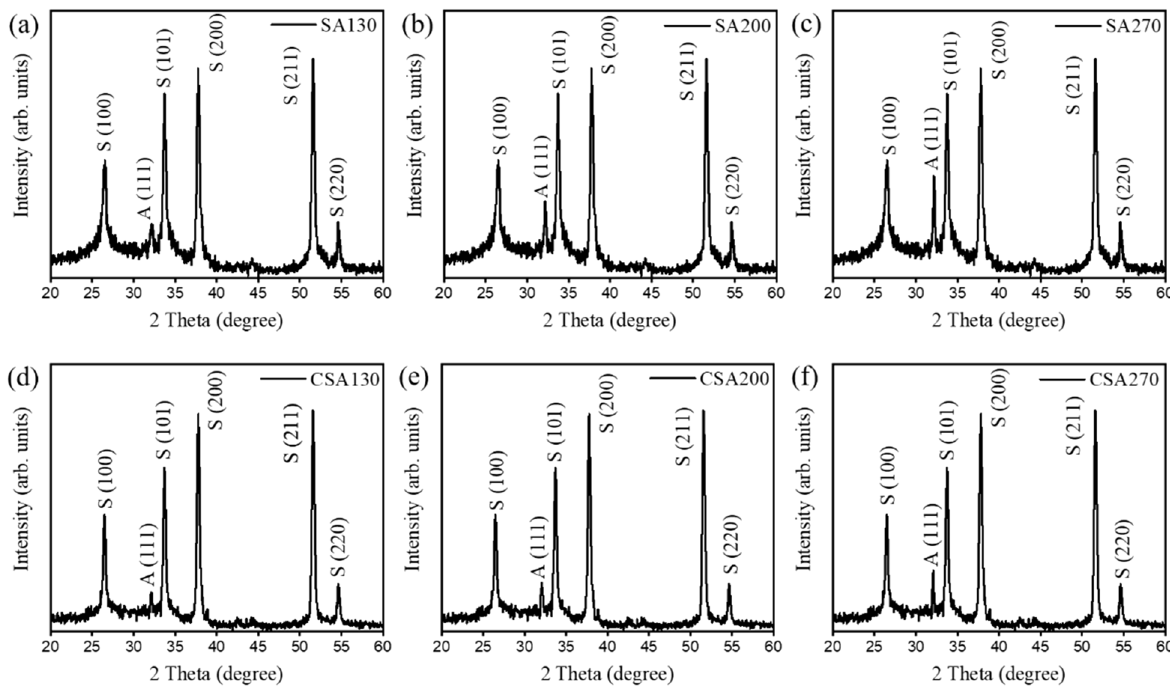
Figure 3: XRD pattern of various SnO 2 – Ag 2 O composite fi lms: ( a ) SA130, ( b ) SA200, ( c ) SA270, ( d ) CSA130, ( e ) CSA200, and ( f ) CSA270. The S and A denote SnO 2 and Ag 2 O, respectively.